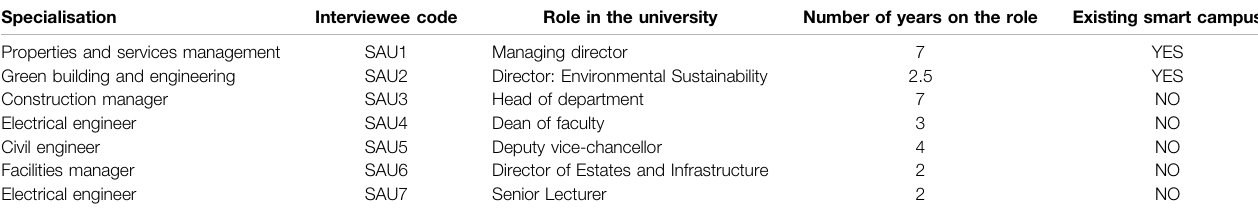
TABLE 1 | Demography of interviewees. Source: